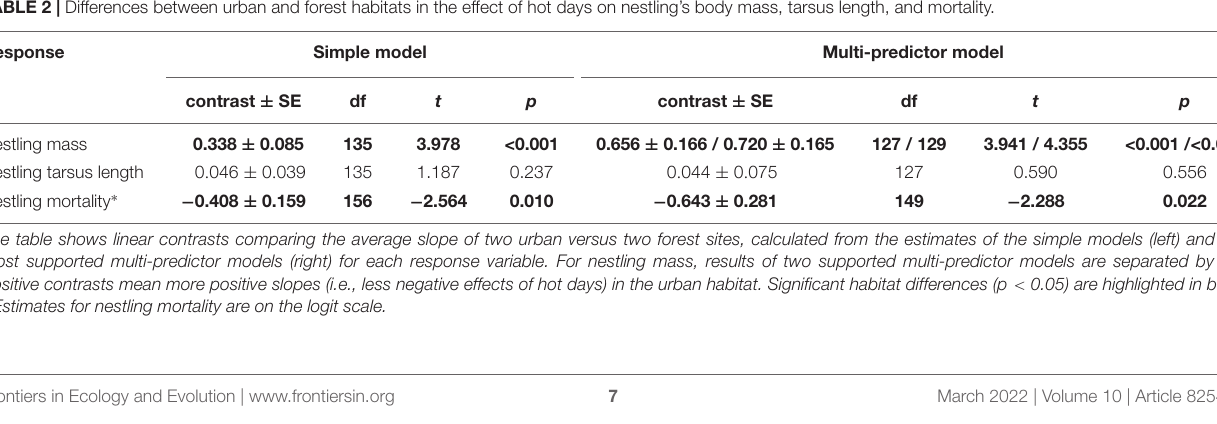
TABLE 2 | Differences between urban and forest habitats in the effect of hot days on nestling’s body mass, tarsus length, and